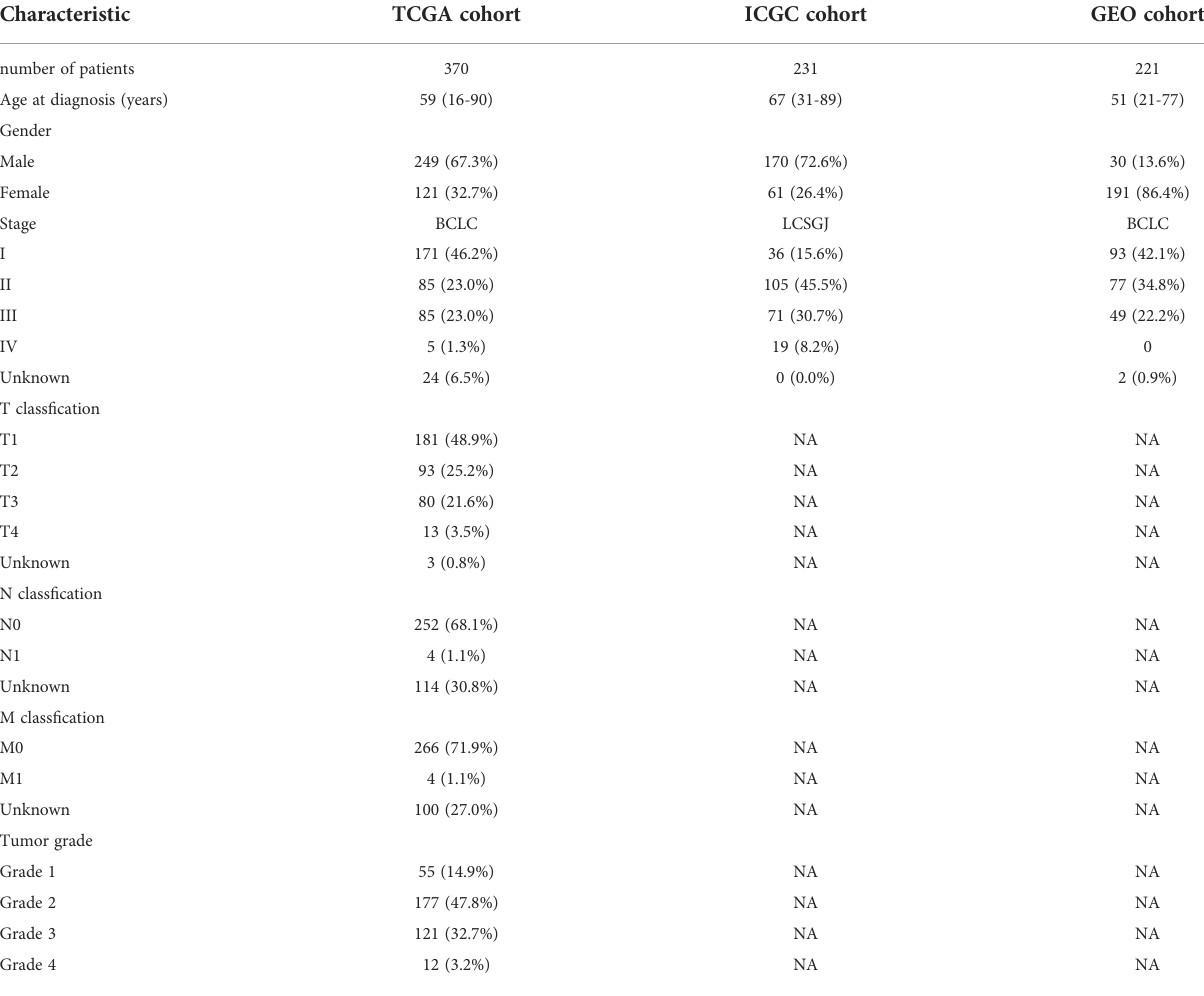
TABLE 1 Clinicopathological parameters of the HCC patients.